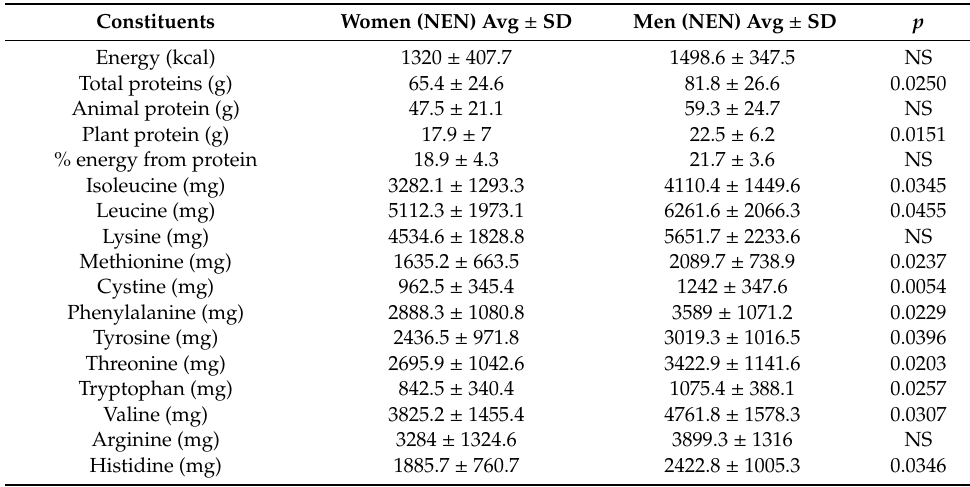
Table 5. The comparison of mean nutrient consumption (proteins including amino acids, fats,